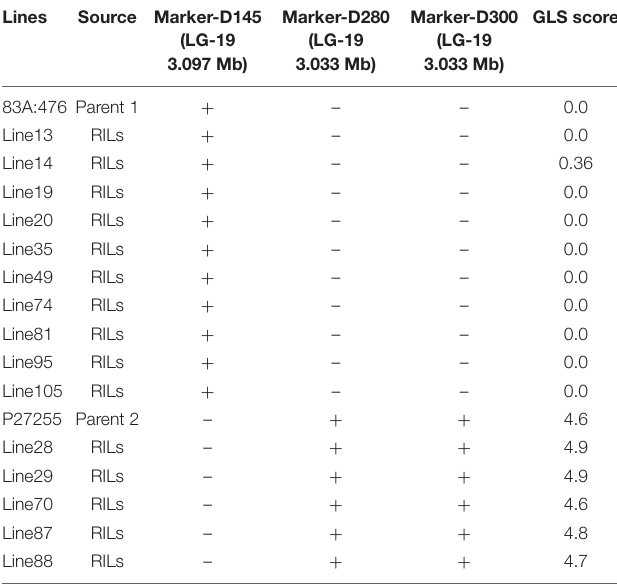
TABLE 1 | Microsatellite fragment length polymorphism (MFLP) markers linked to gray leaf spot (GLS) resistance.